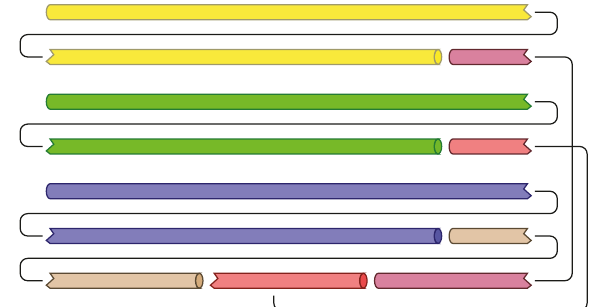
Figure 4: Nonsequential cutting-and-welding pattern for produc- ing three 11-meter pipes and three 3-meter pipes from seven single- size, 6-meter